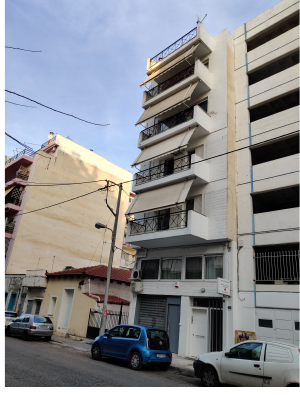
Figure 5. Building 1 street view.